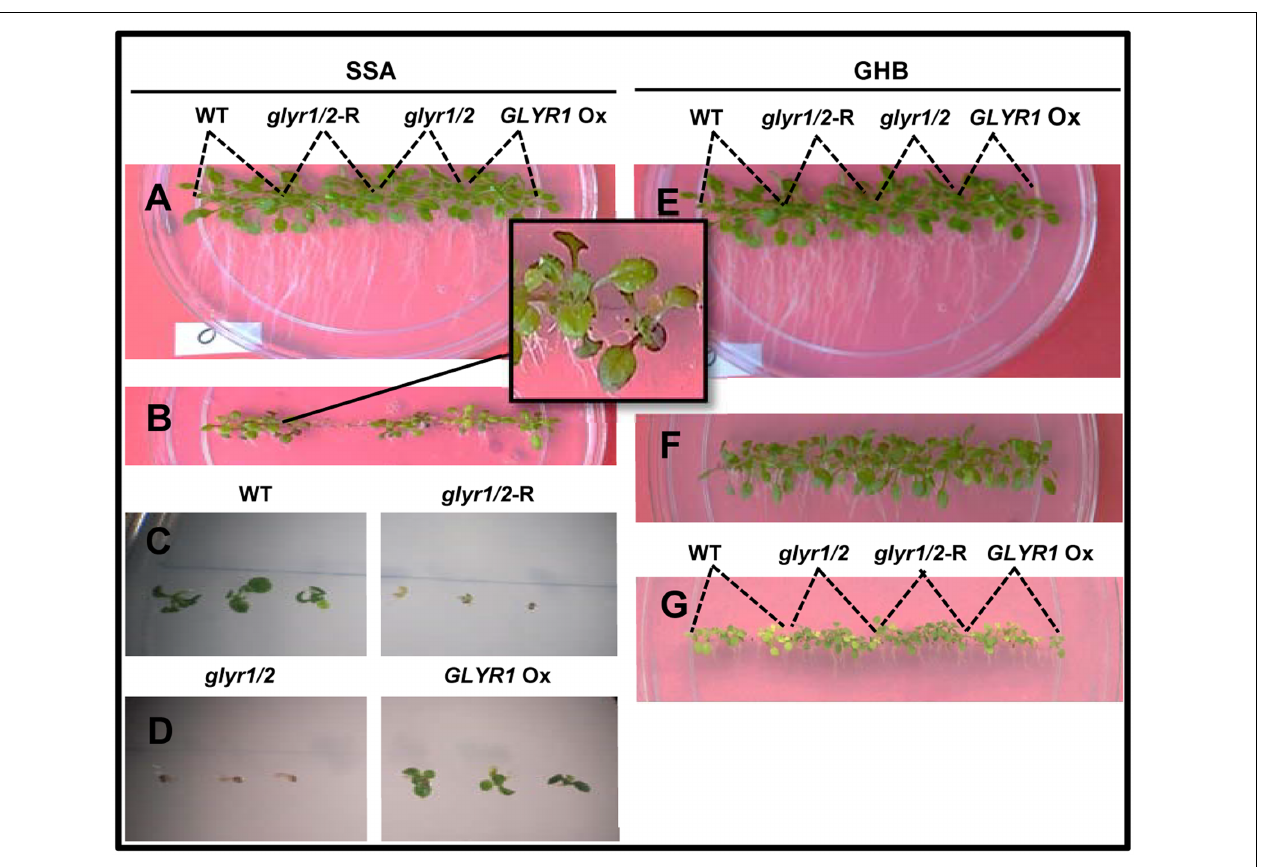
FIGURE 3 | Impact of Arabidopsis genotype on the early phenotypic response to succinic semialdehyde or γ -hydroxybutyrate under chilling stress. Seeds of wild-type (WT) plants and glyr1/2- RNAi, glyr1/2, and GLYR1 Ox were sown on plates containing half-strength MS medium with up to 3 mM SSA or GHB and grown at 10 ◦ C for 27 days. Levels of SSA or GHB are 0 (A,E) , 1 (B) , 2 (C,D,F), and 3 (G)